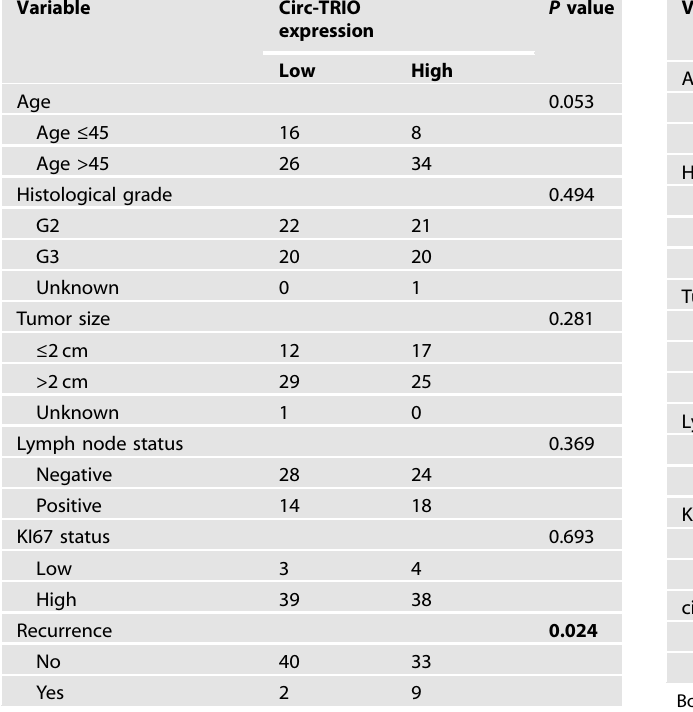
Table 1. Association between clinicopathological variables and circ- TRIO expression in TNBC patients.